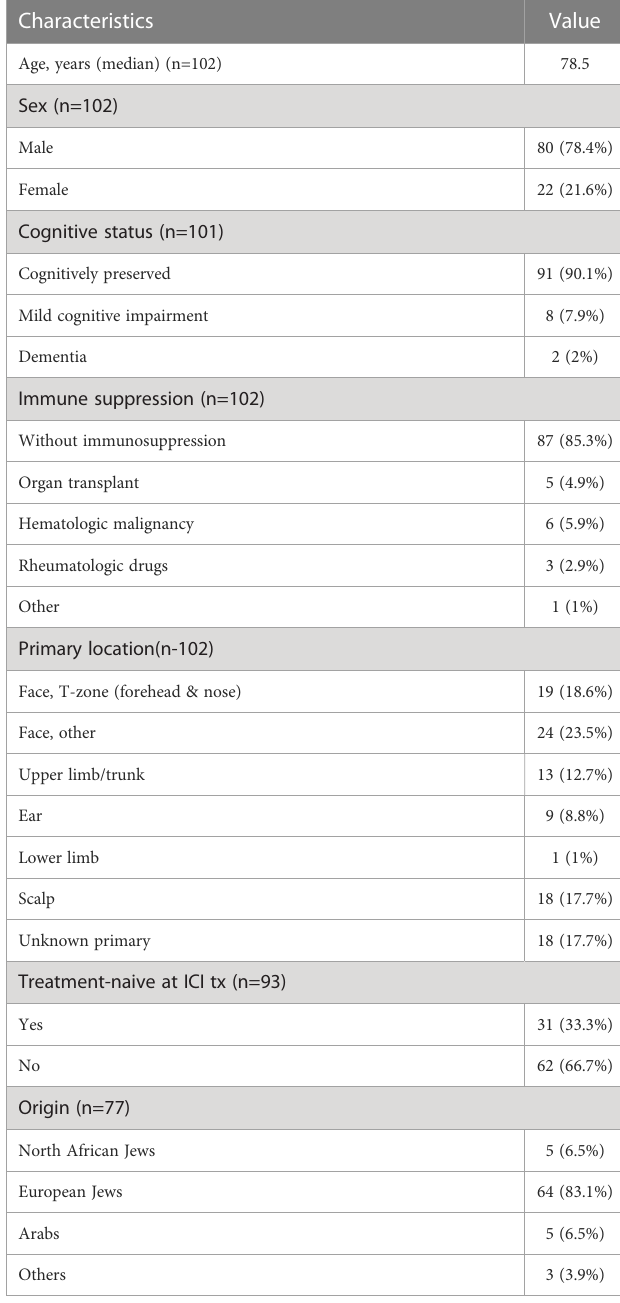
TABLE 1 Clinical characteristics of patients with